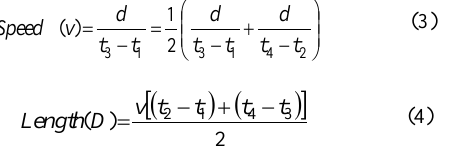
Figure 3. Inductive Curves/Signatures of different vehicles